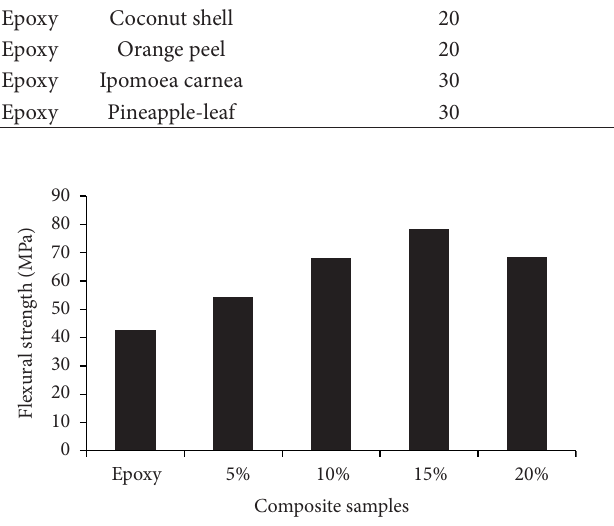
Figure 4: Effect of flexural strength of composite.